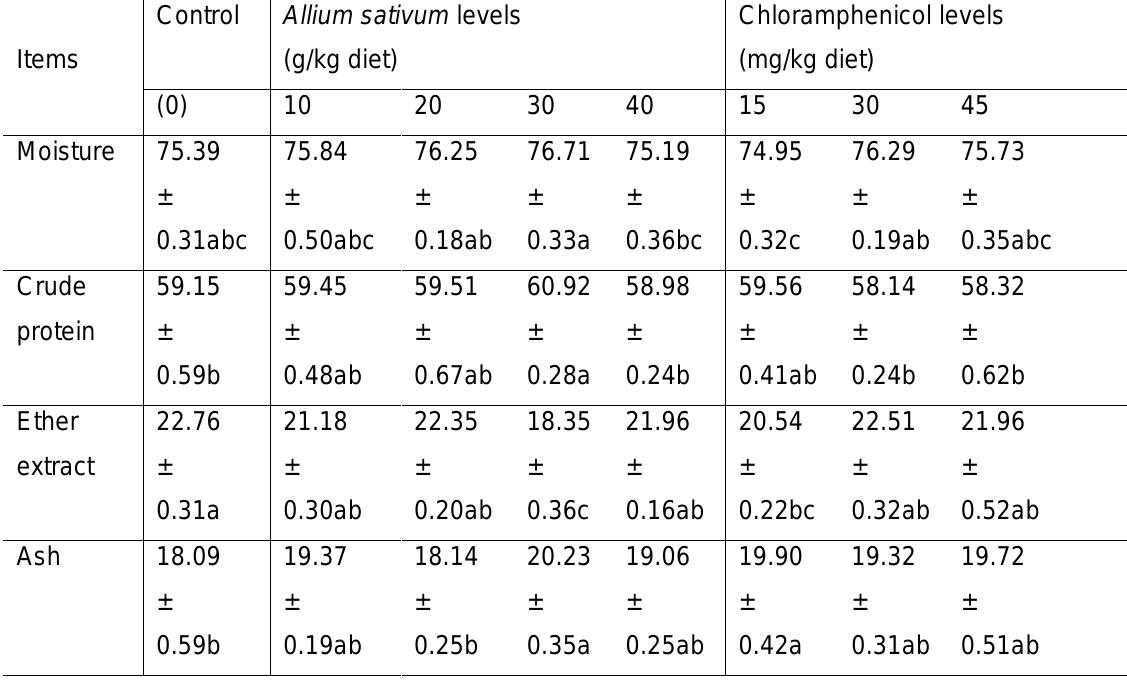
Table 4: Chemical composition of whole body (% dry matter basis) of Nile tilapia ( O. niloticus ) under different